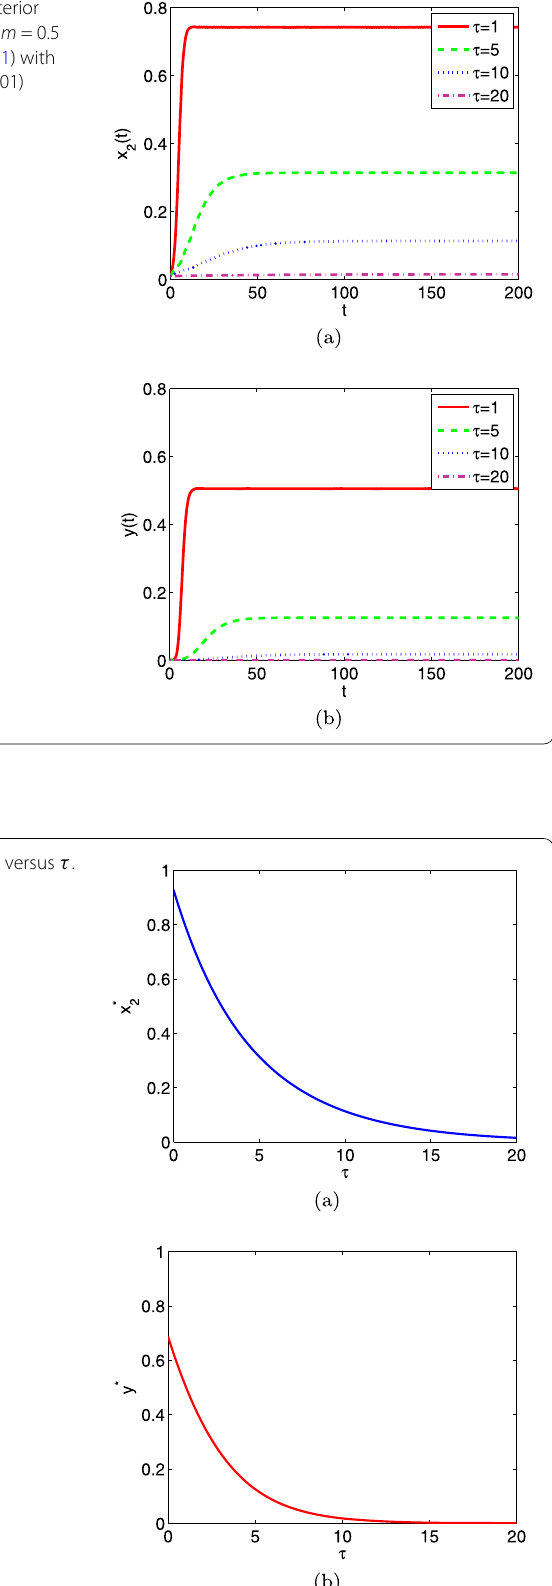
Figure 4 All solutions converge to the interior equilibrium E ∗ for different τ . Here we fix m = 0.5 and choose the other parameters from (3.1) with the initial condition ( x 2 (0), y (0)) = (0.01,0.001)